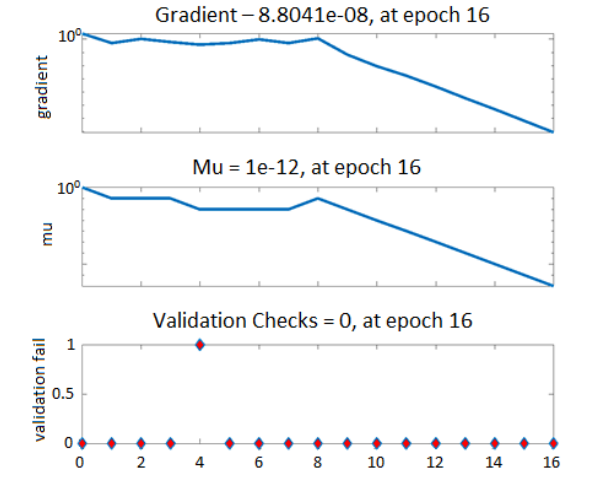
Figure 18. NET2_STATE neural network